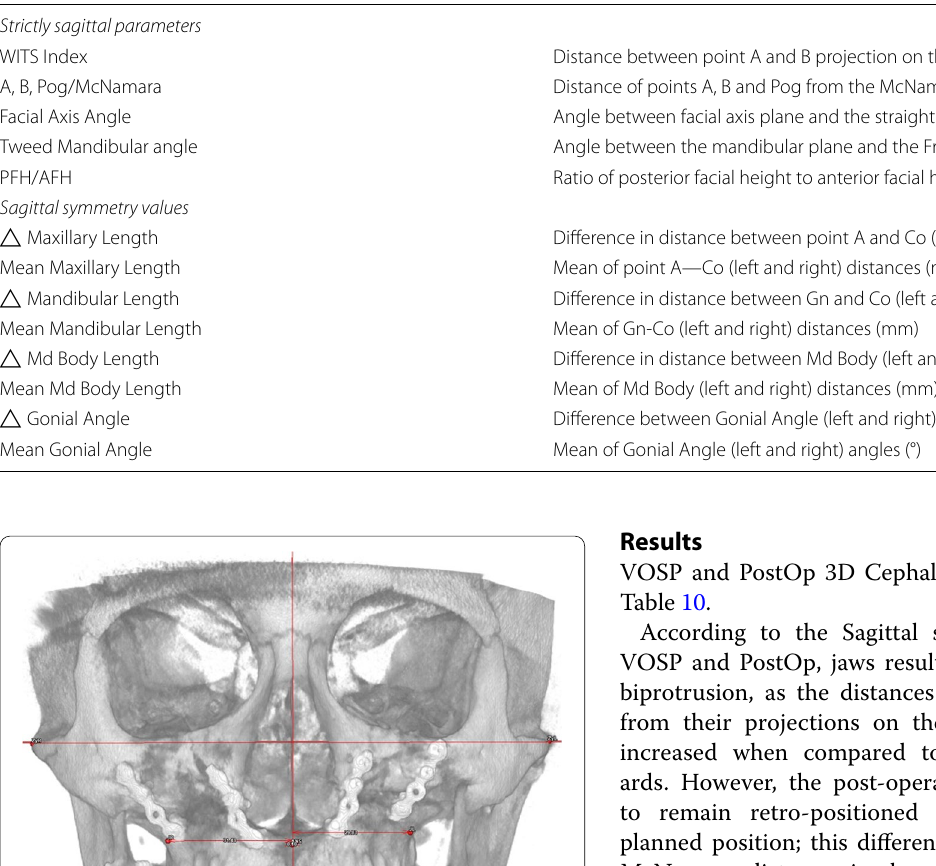
Table 4 Sagittal skeletal analysis: sagittal parameters and symmetry values